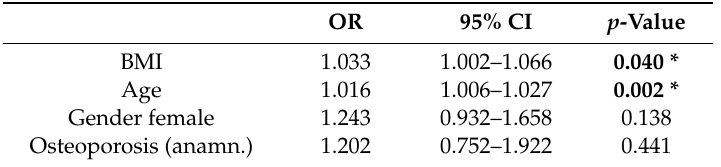
Table 2. Logistic regression analysis of independent risk factors for trochanteric fracture rather than femoral neck fracture adjusted for the covariates age, gender, and osteoporosis.